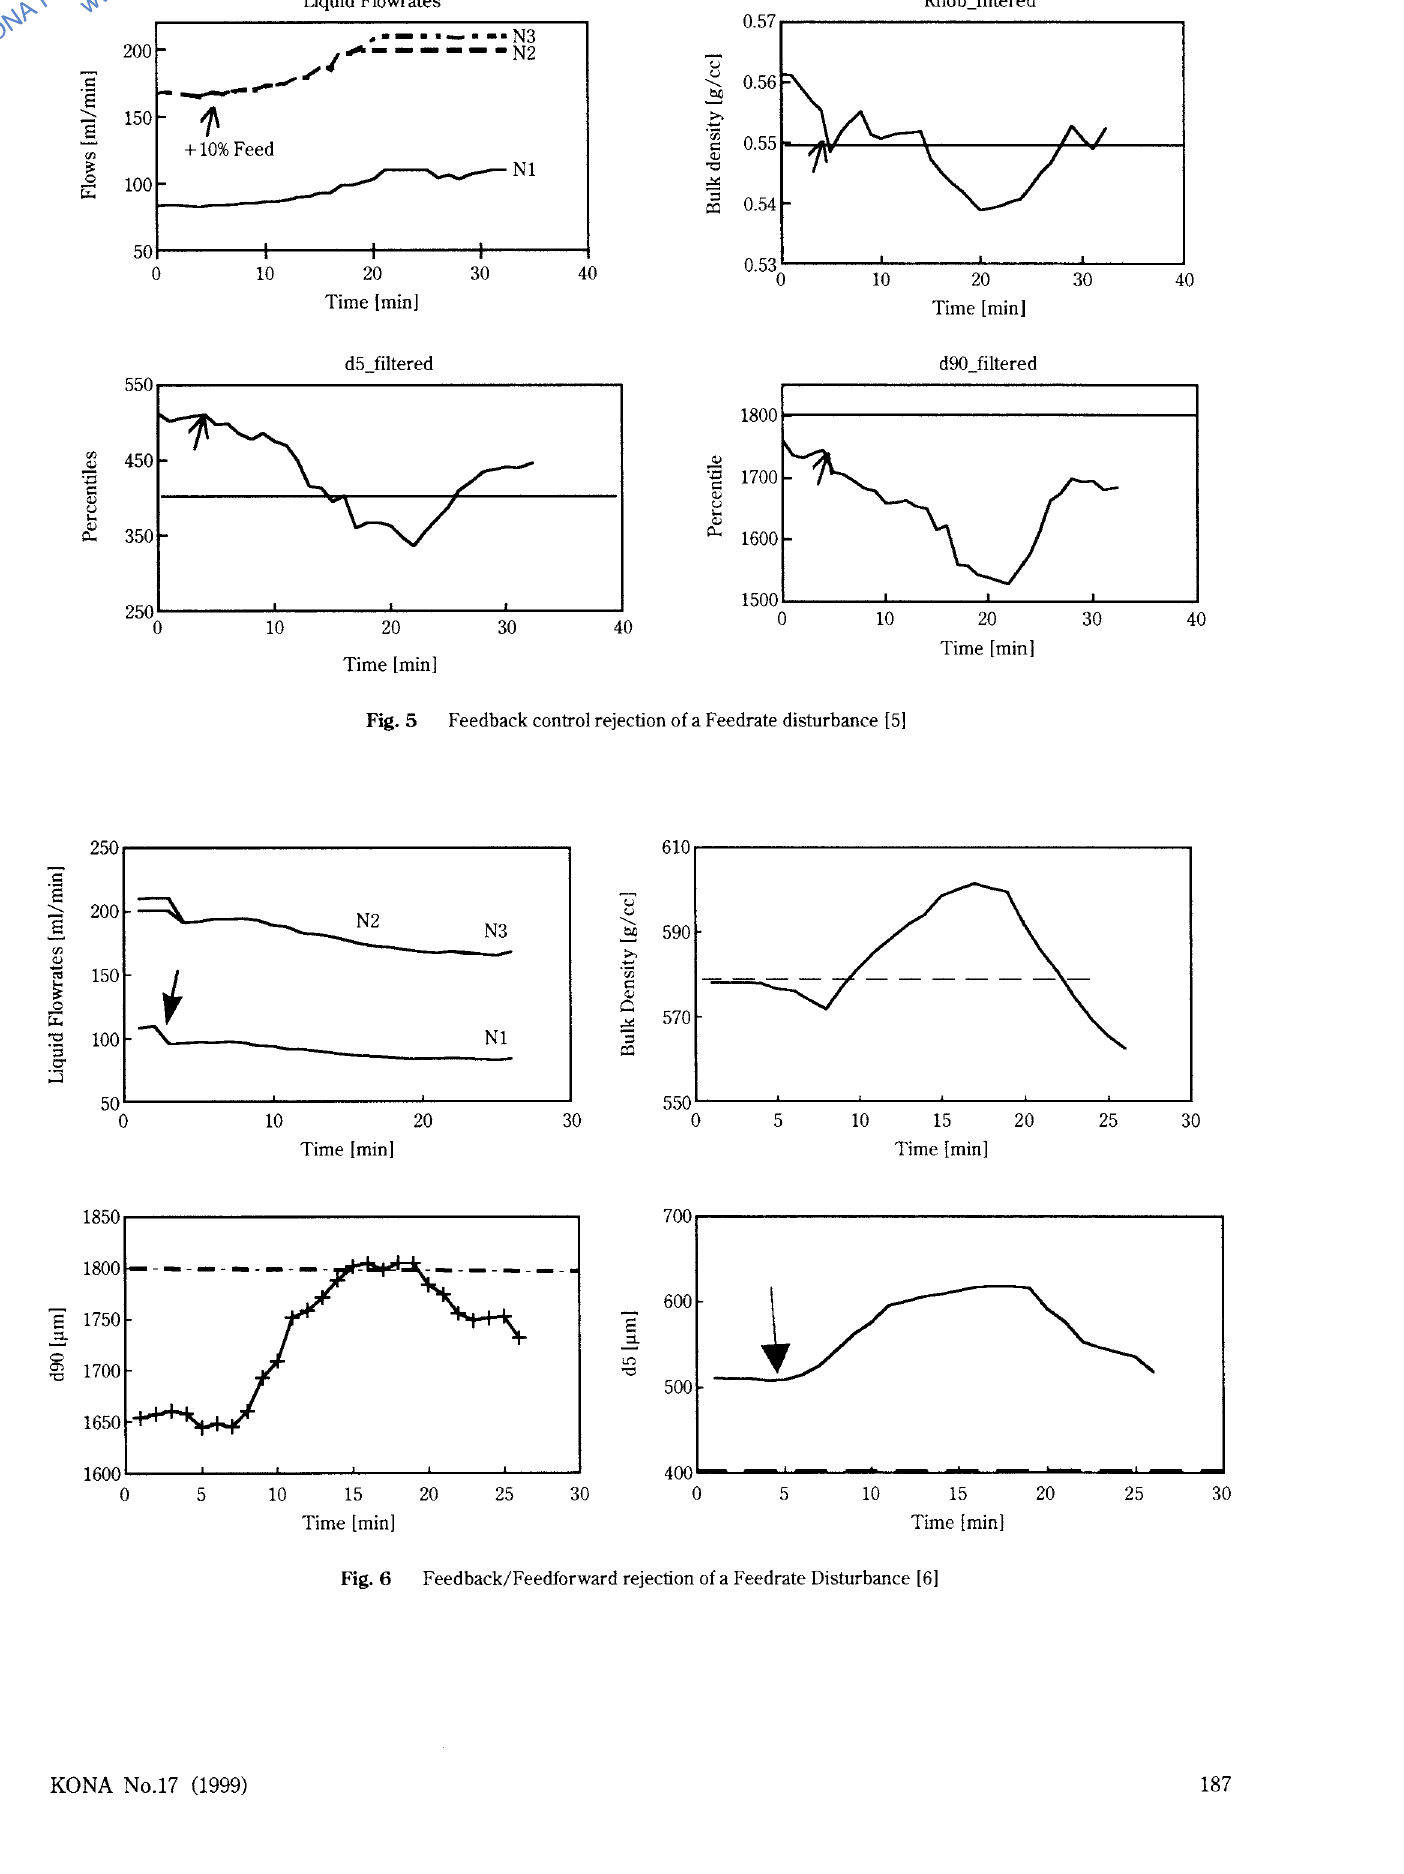
Fig. 5 Feedback control rejection of a Feedrate disturbance [5]